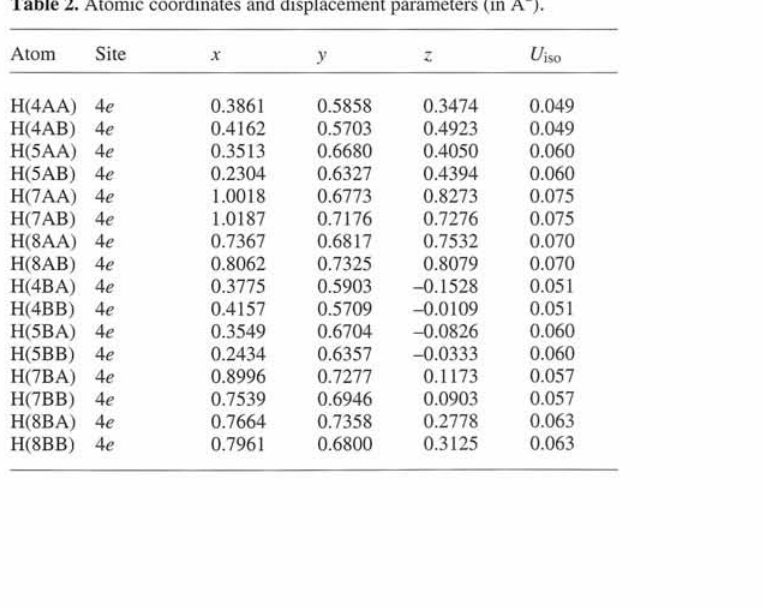
Table 2. Atomic coordinates and displacement parameters (in Â 2